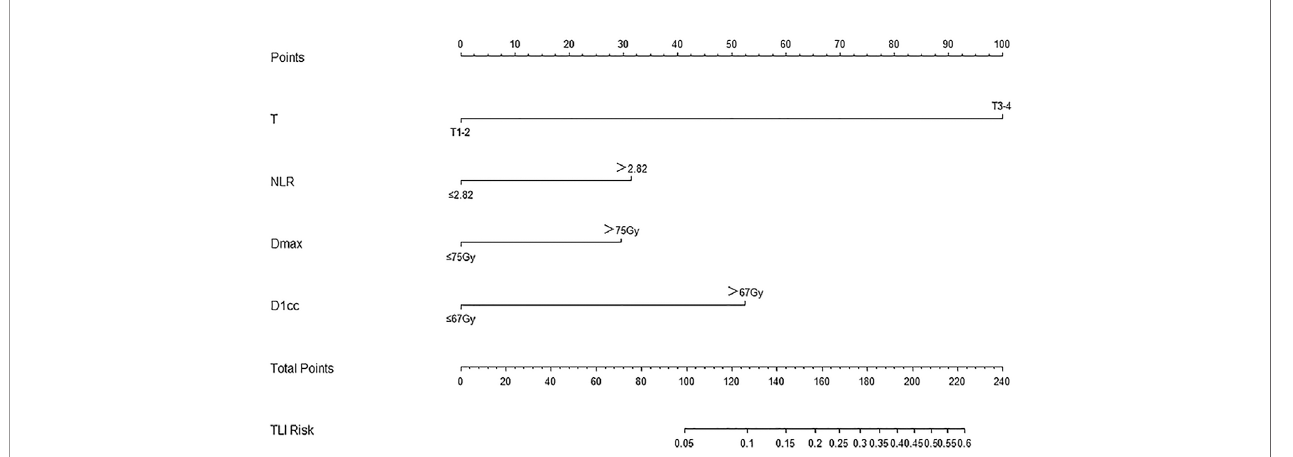
FIGURE 2 | Nomogram for TLI risk after de fi nitive concurrent chemoradiotherapy in nasopharyngeal carcinoma patients, including T stage, NLR, Dmax, and D1cc.